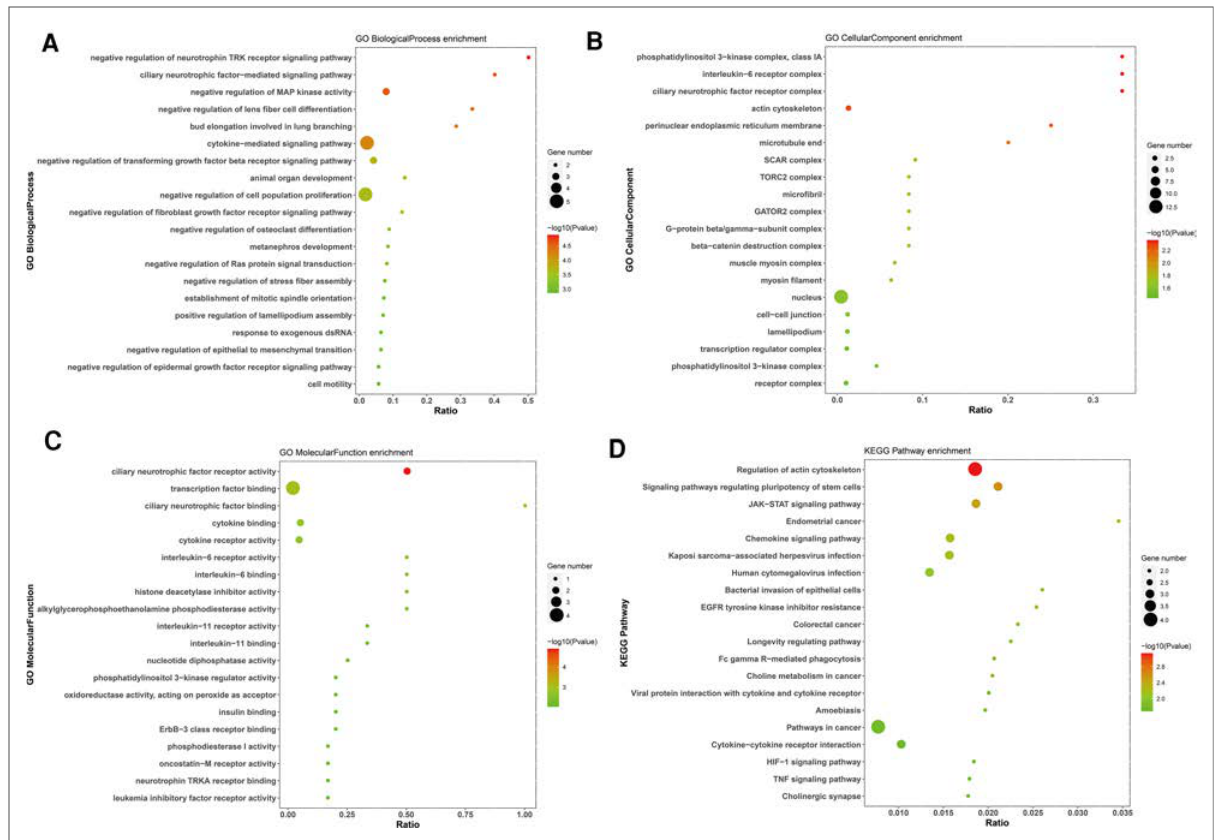
FIGURE 6 Go and KEGG enrichment analysis of down-regulated survival-associated mRNAs. ( A – C ) GO analysis of up-regulated mRNAs. ( D ) KEGG analysis of up-regulated mRNAs.